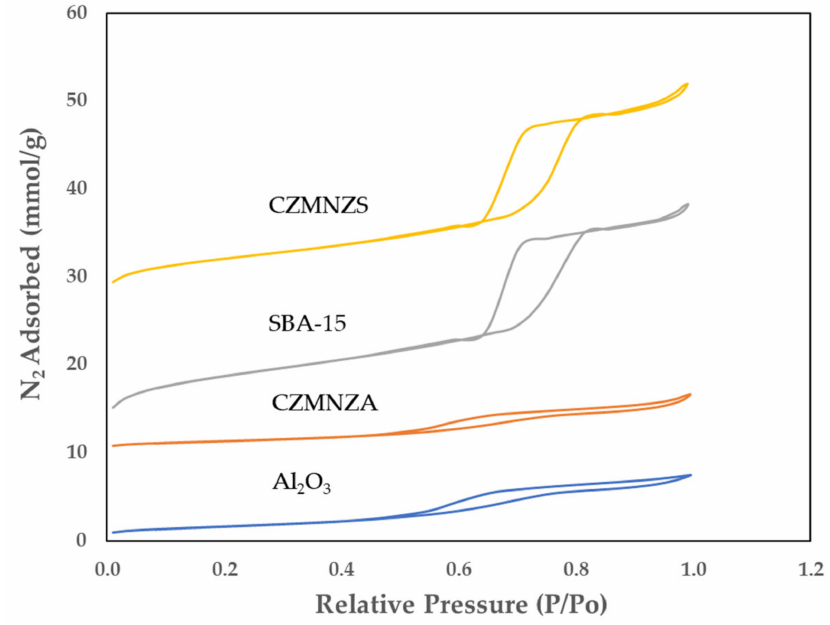
Figure 1. Nitrogen adsorption–desorption isotherms of the supports and catalysts.